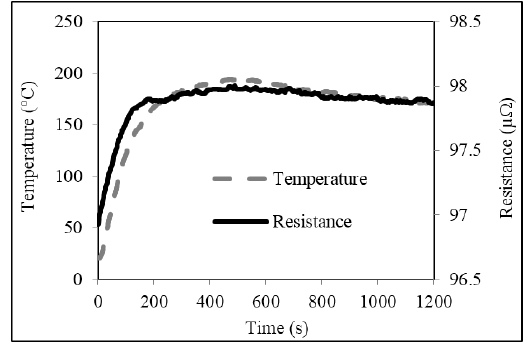
Figure 7. Temperature and resistance versus time plots for the untrimmed shunt resistor.